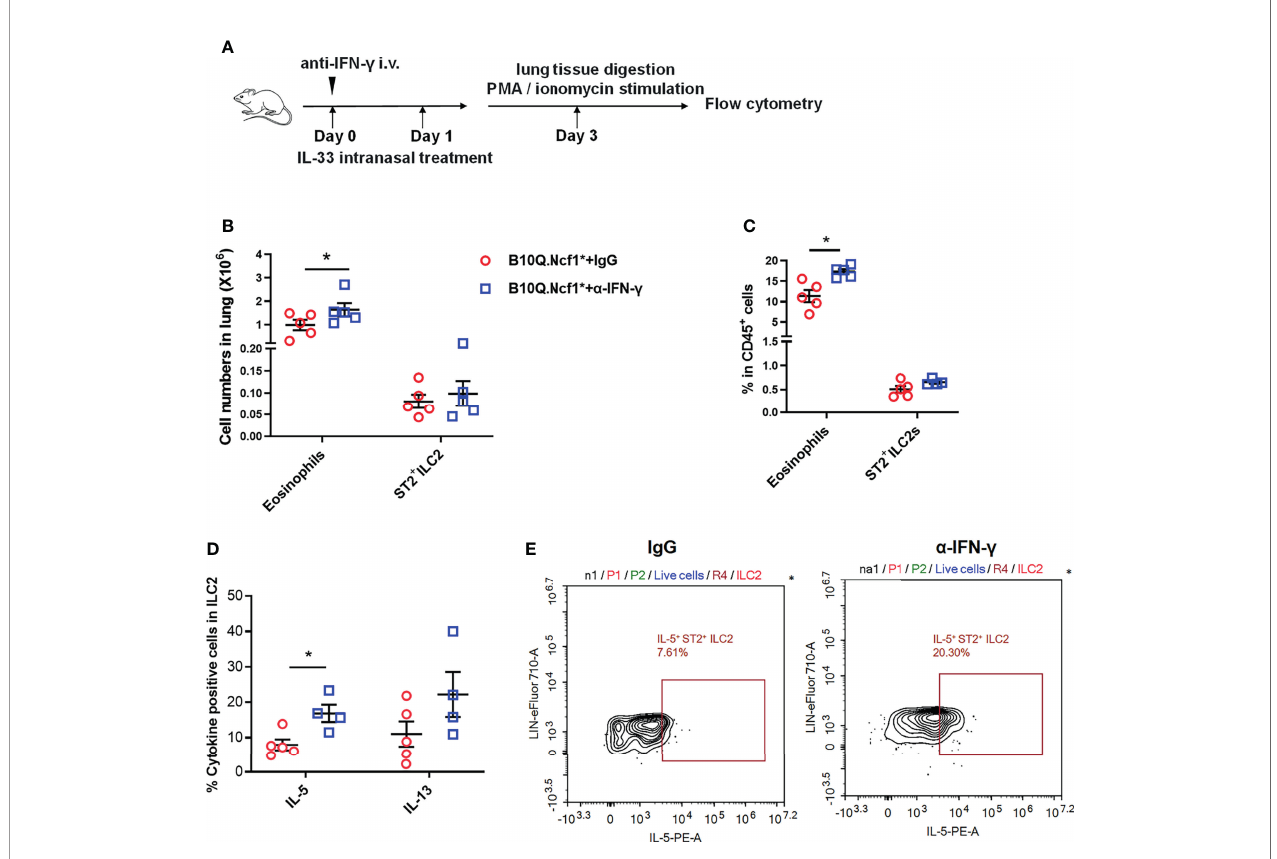
FIGURE 7 | Intervention of IFN- g rescues ILC2 activation and lung in fl ammation. (A) Anti-IFN- g neutralizing antibodies or isotype control antibodies were used for treatment of B10Q. Ncf1 * mice in the IL-33 treated model (n=5 per group). (B, C) The numbers of eosinophils and ILC2 in the whole lung tissue were analyzed by fl ow cytometry. The proportion of eosinophils and ILC2 in CD45 + cells were determined in histogram. (D, E) In addition, the IL-5 and IL-13 positive cells within the ILC2 population were also detected by fl ow cytometry of cells from the whole lung tissues of the mice. The proportion of IL-5 and IL-13 positive cells in ILC2 were analyzed in histograms, and the representative plots of IL-5 are shown. All values are expressed as means ± SEM. * P < 0.05, using student ’ s t